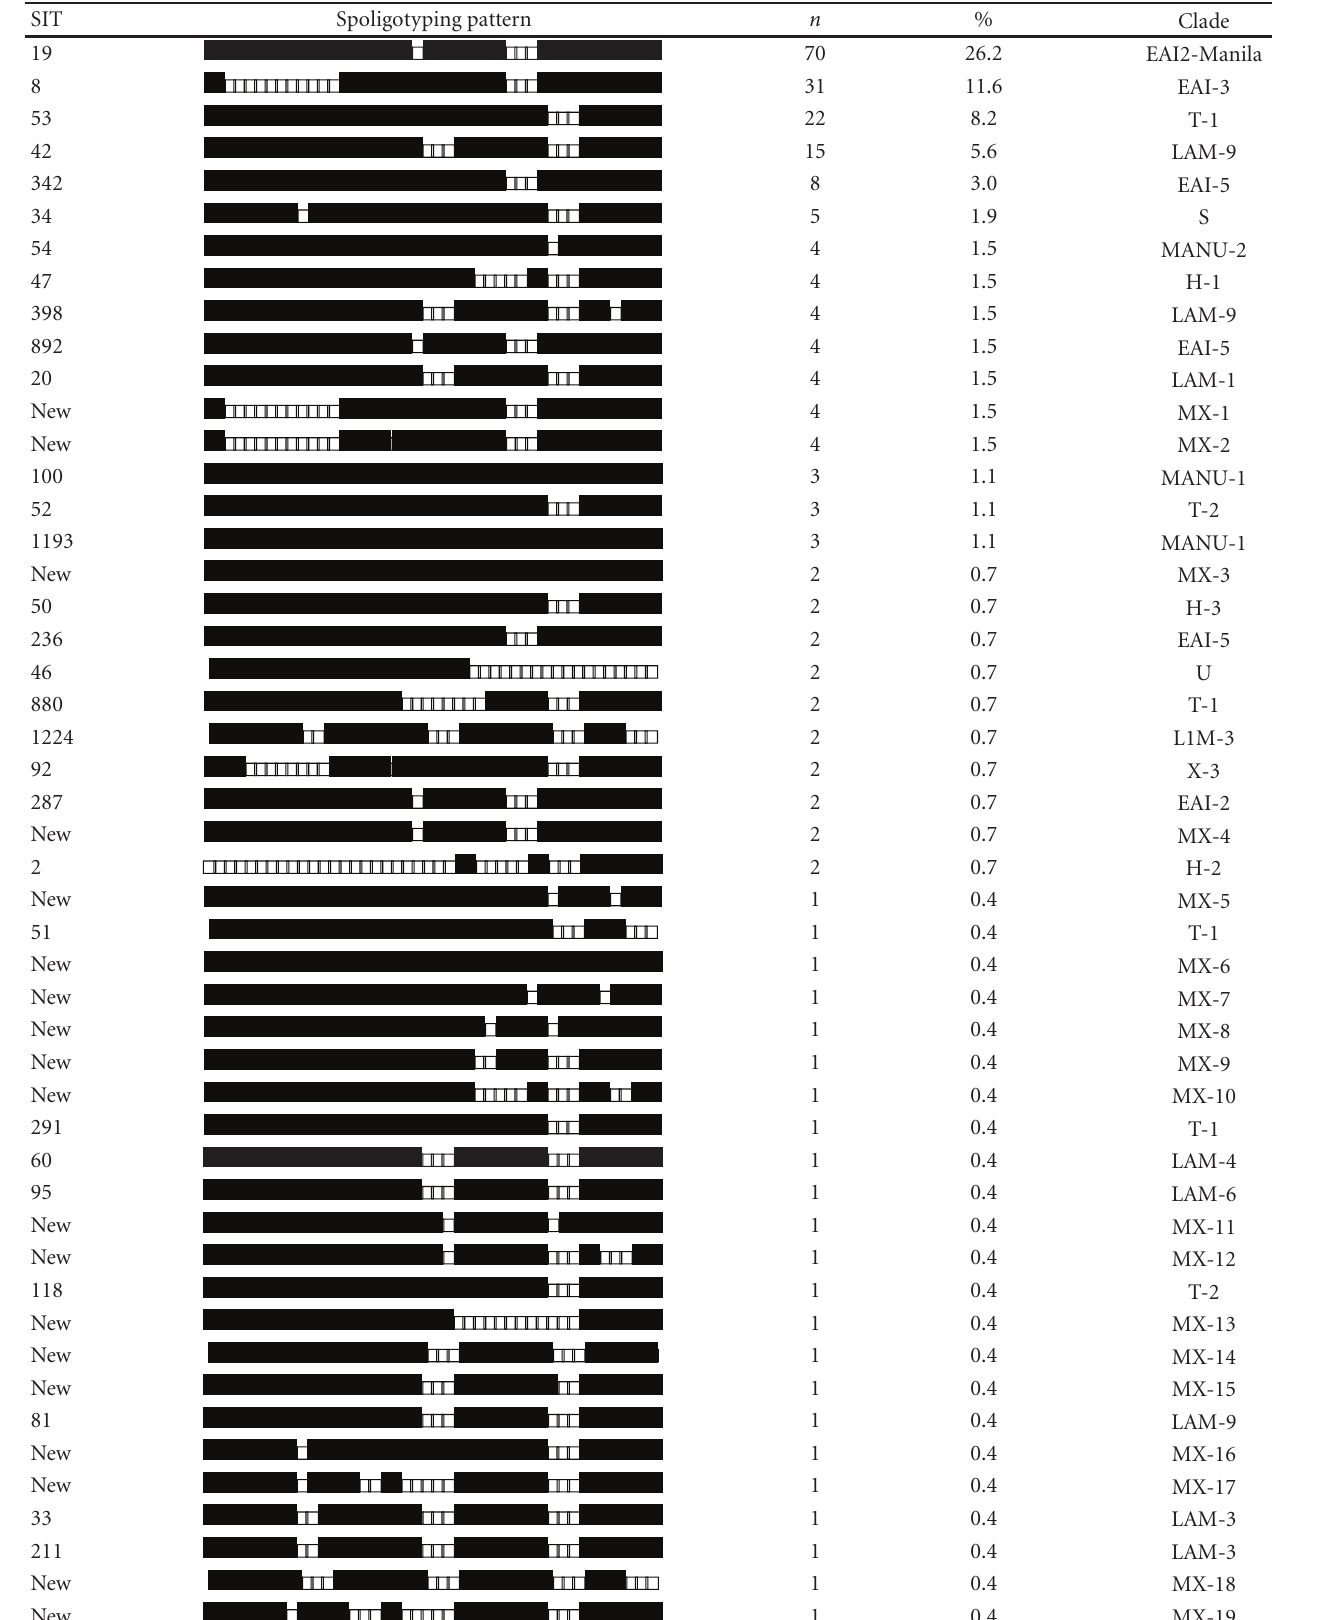
Table 1: Acapulco patterns of Mycobacterium tuberculosis